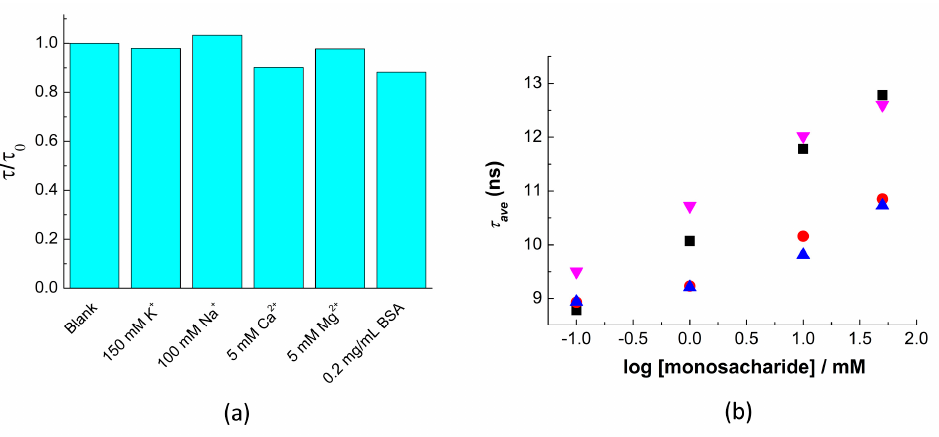
Figure 5. ( a ) Interference study of the QD–APBA conjugates as glucose nanosensors at pH 9. The average PL lifetimes of the QD–APBA nanosensor in the presence of foreign species were normalized by the average PL lifetime of the blank (in the absence of interfering species). ( b ) Average PL lifetime of the QD–APBA nanosensors in the presence of different concentrations of monosaccharides: fructose (black); galactose (red), mannose (blue); glucose (magenta).